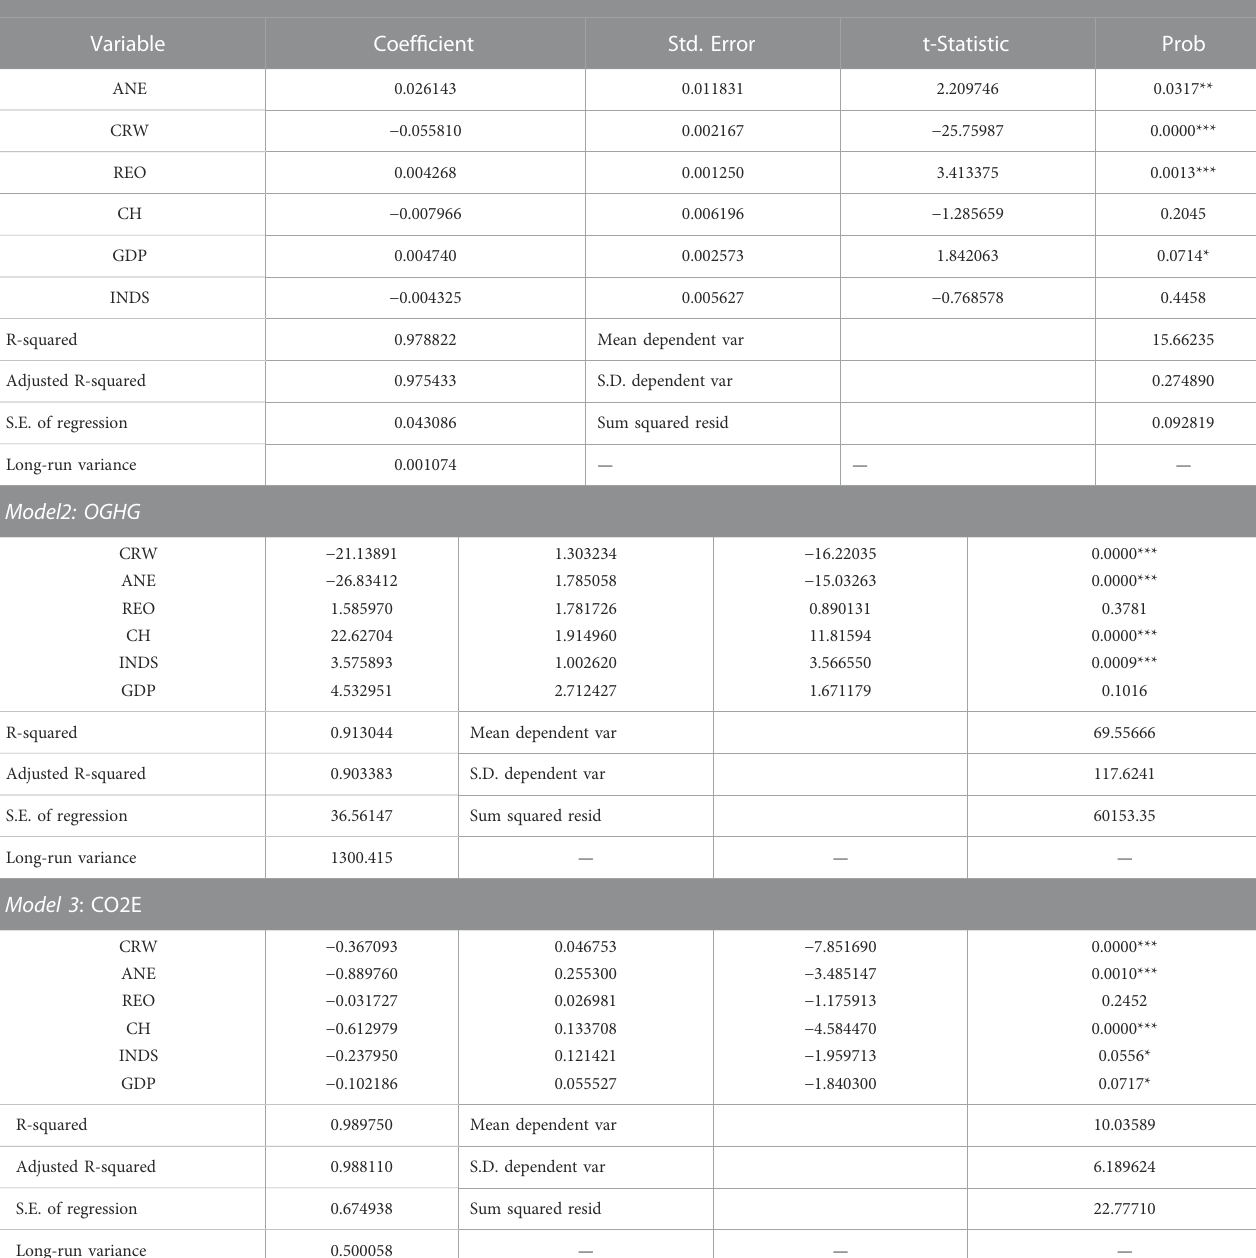
TABLE 8 Results of